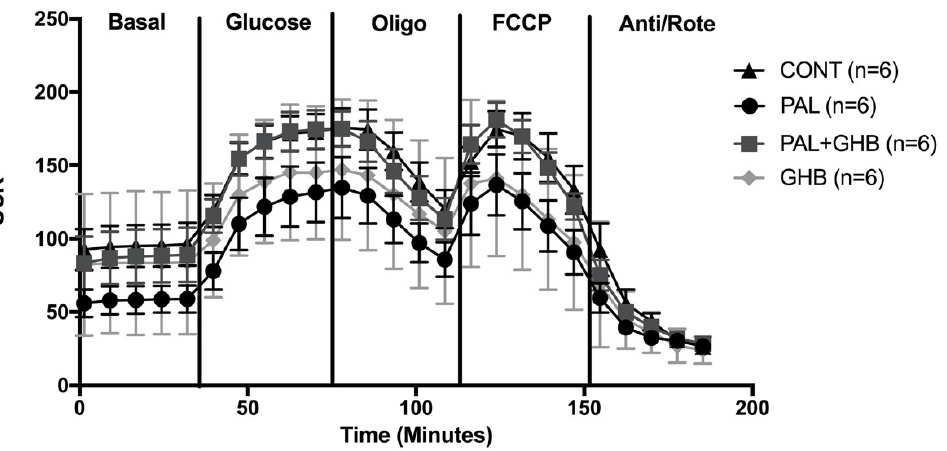
Figure 3. Effects of palmitate and gamma-hydroxybutyric acid (GHB) on oxygen consumption rate in mouse islets. Measurement of oxygen consumption rate (OCR) with Seahorse XF cell Mito Stress Test (Seahorse Bioscience, Billerica, MA, USA). Islets were treated for 48 hrs with (1) control media (black triangle), (2) Palmitate (0.4 mM) (black circle), (3) Palmitate (0.4 mM) and GHB (5 mM) (dark-gray square), and (4) GHB (5 mM) alone (light-gray diamond). Palmitate treatment tended to reduce OCR while GHB seemed to have a protective effect. Data are means ± SE. One-way parametric ANOVA for repeated measures followed by Tukey’s test was performed to compare differences between treatments.